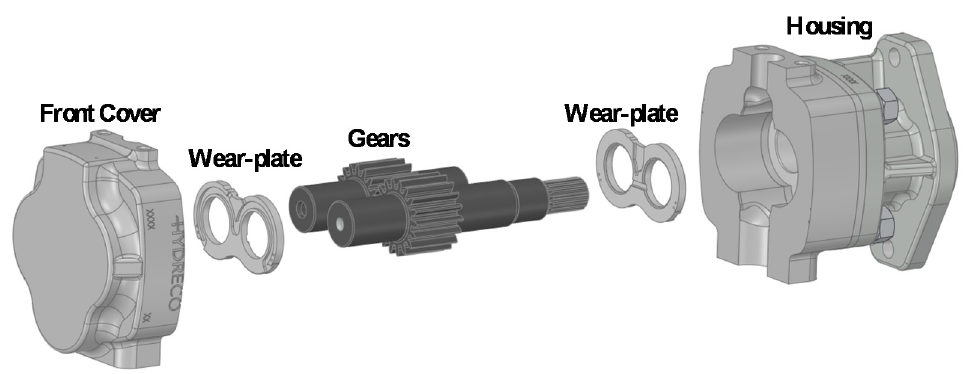
Figure 1. Reference external gear